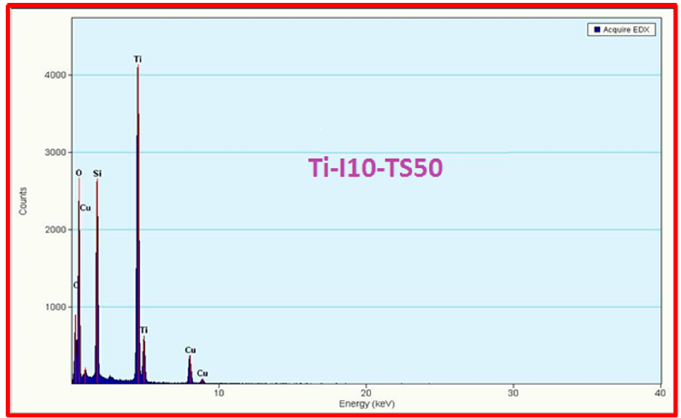
Figure 6. The EDX spectrum for the Ti-I10-TS50 sample.